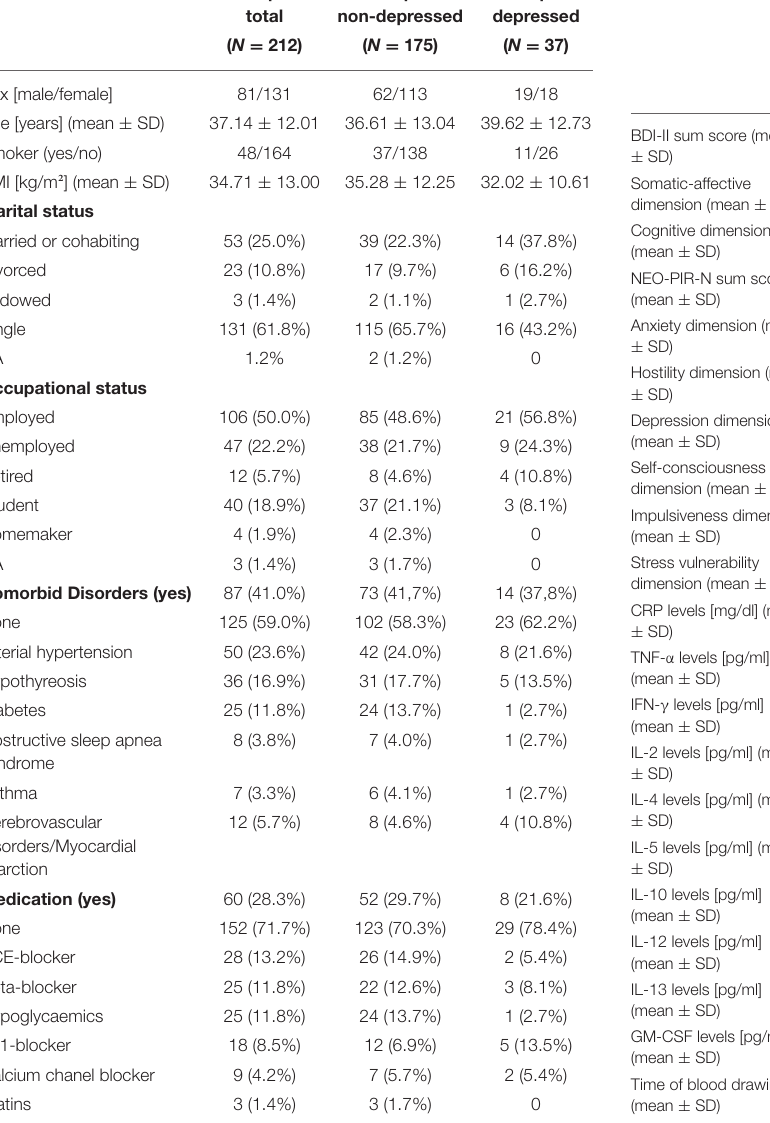
TABLE 1 | Sociodemographic details for the total sample, and for participants with and without a diagnosis of major depression, separately.